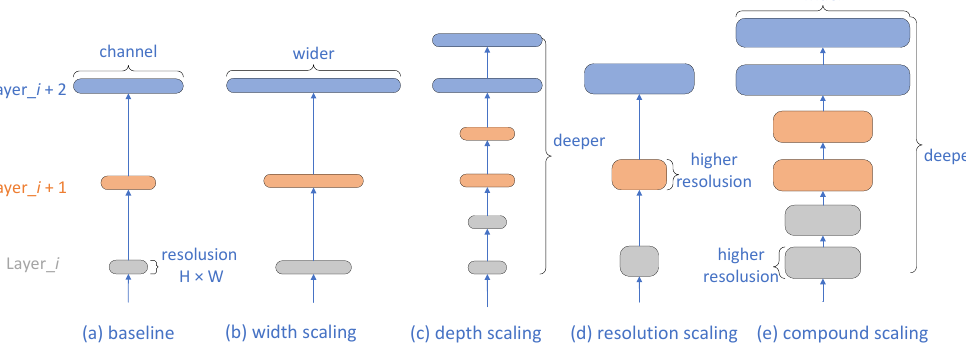
Figure 3. Neural network scaling.